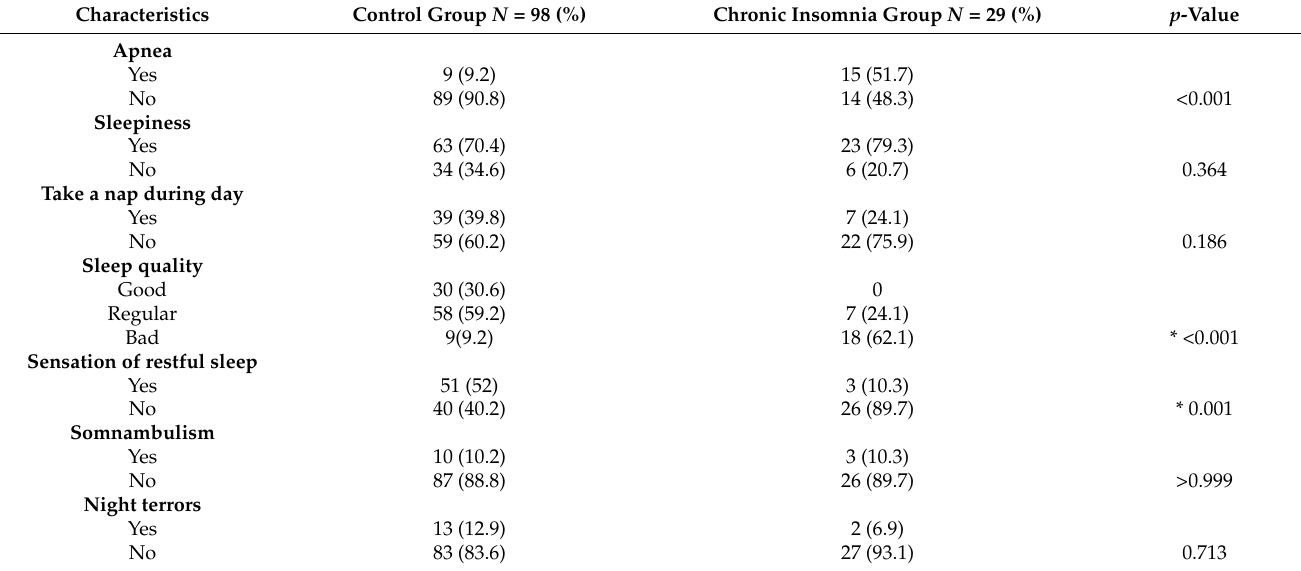
Table 1. Clinical characteristic and behavioral disturbances related to sleep in chronic insomnia patients.